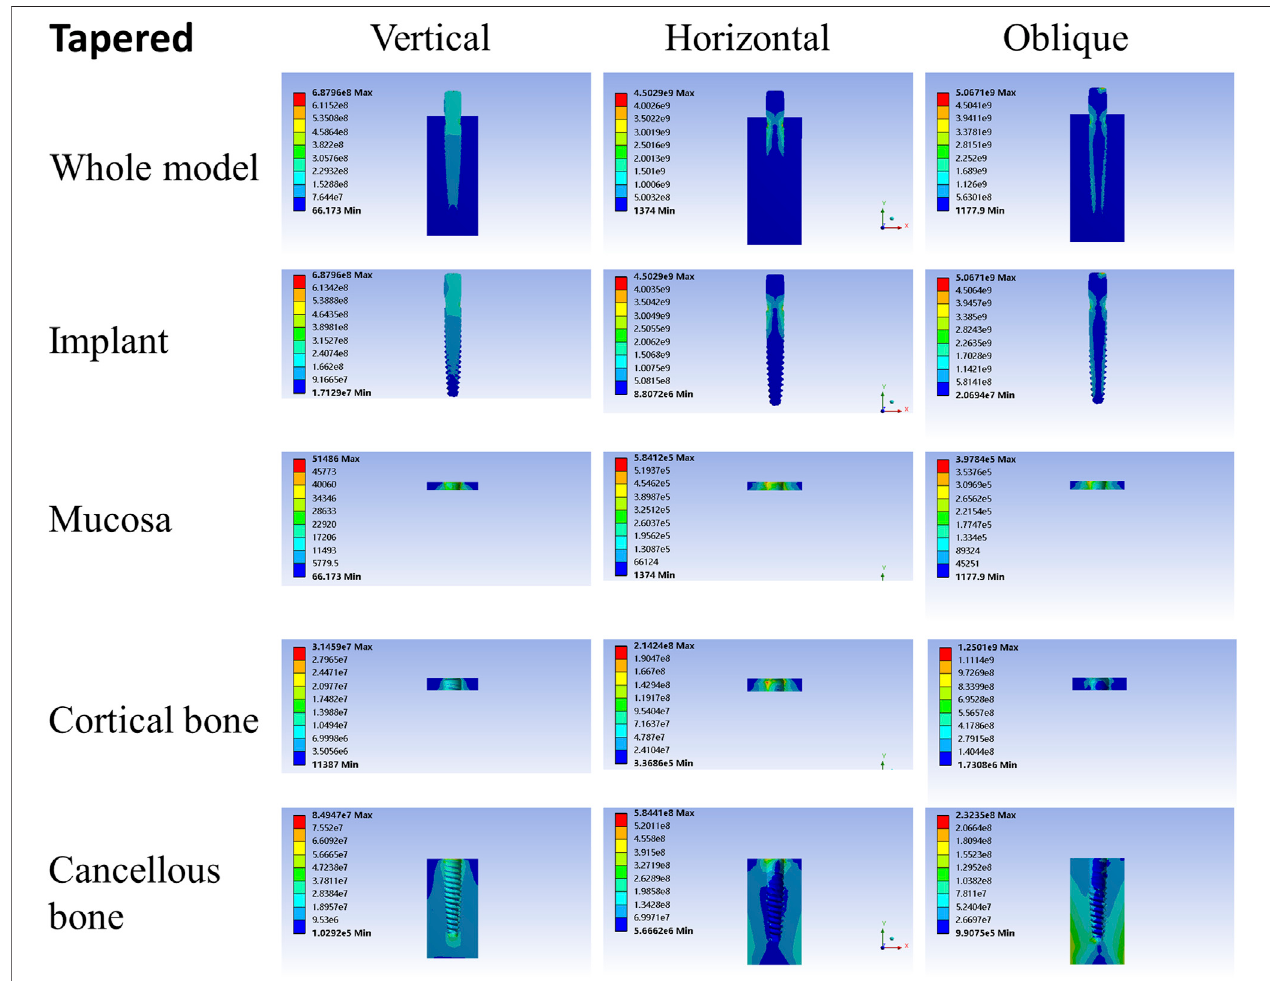
FIGURE 8 | Stress distribution of the tapered implant under 100-N